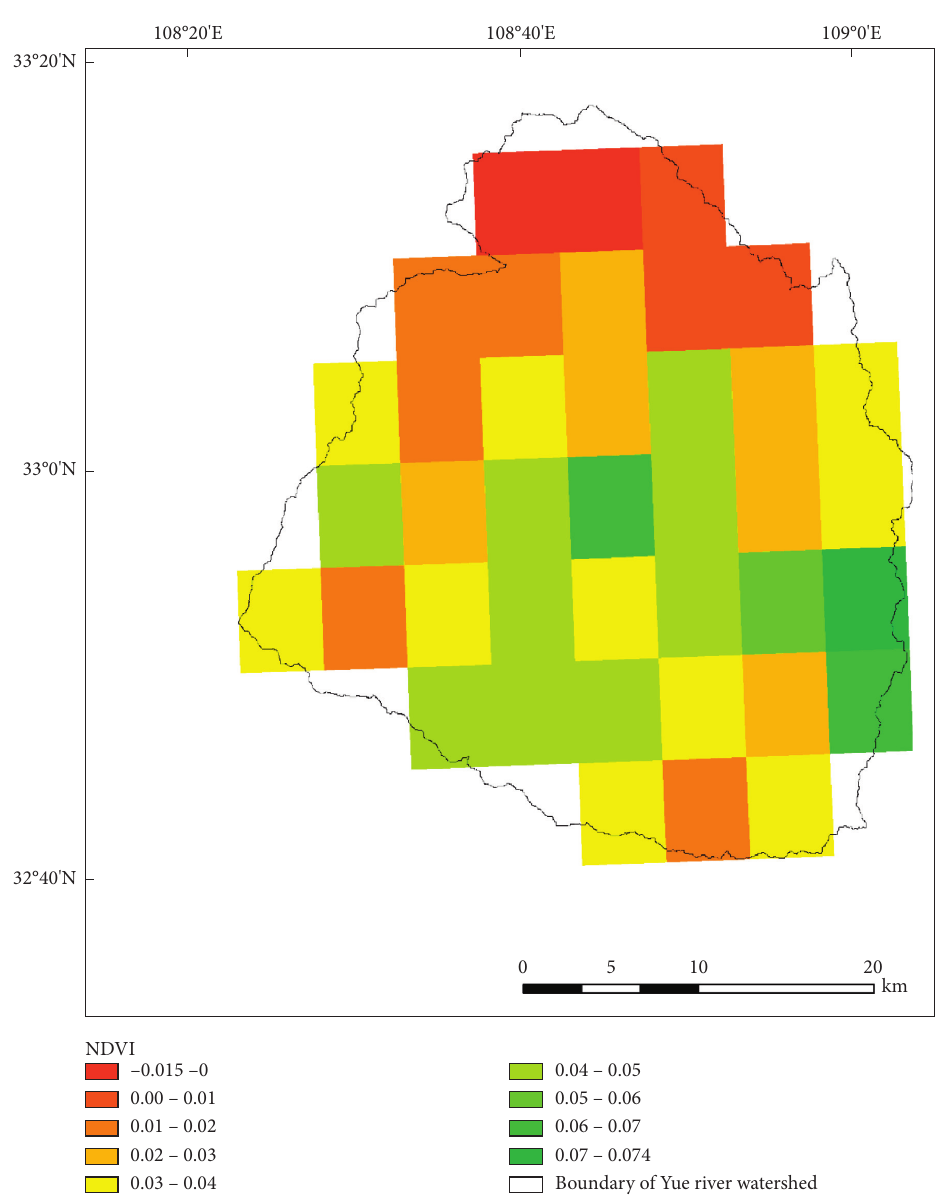
Figure 7: Different NDVIs between 1982–1990 and 1991–2015.